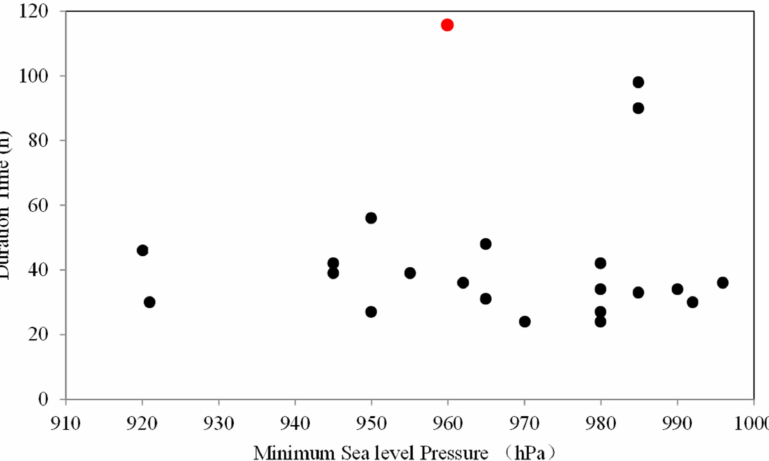
Figure 10. Features of heavy rainfall TCs affecting Zhejiang and Jiangsu provinces from 1949 to 2021. Tthe horizontal coordinate indicates the minimum sea level pressure (unit: hPa), and the vertical coordinate shows the duration time of TCs in this area (unit: h). The red dot indicates